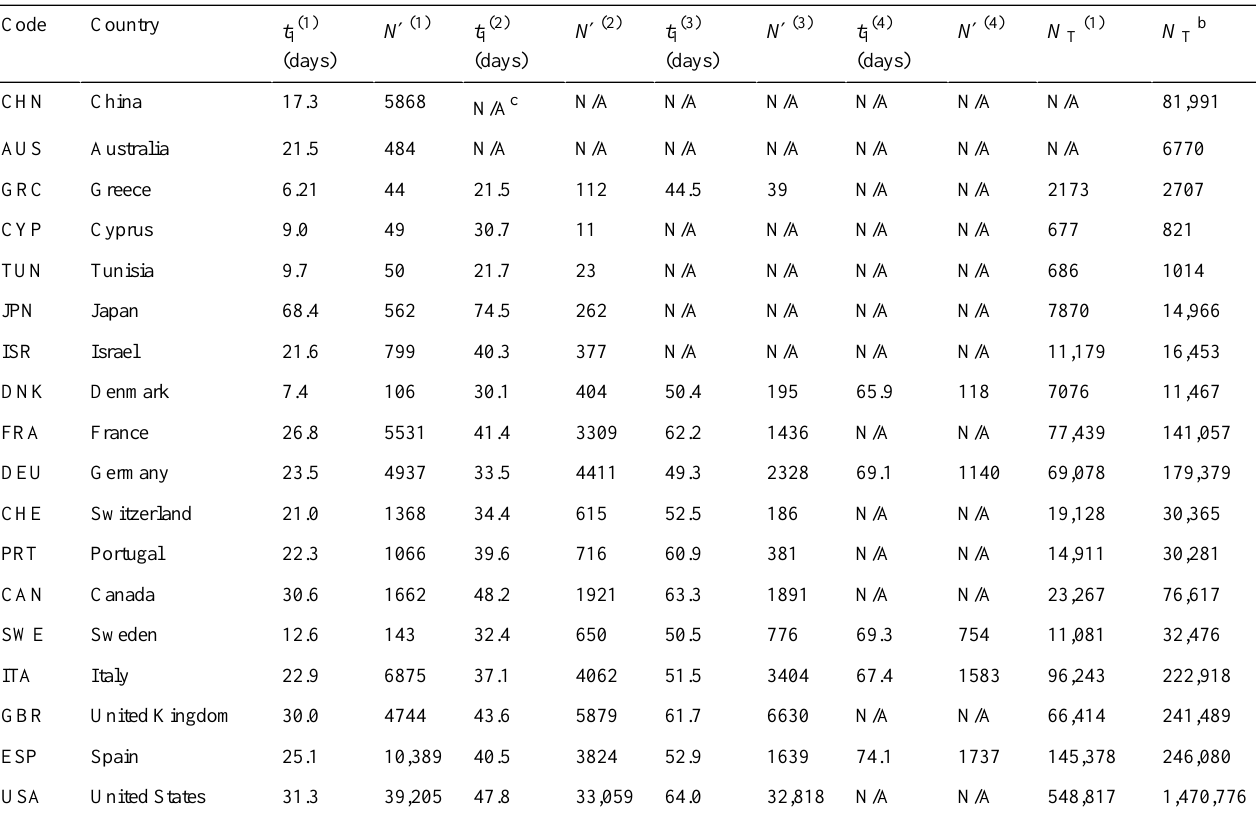
Table 1. The values of the various parameters that enter in the multi-wave forced-susceptible-infectious-removed (FSIR) model of equation (6), for the representative countries considered.